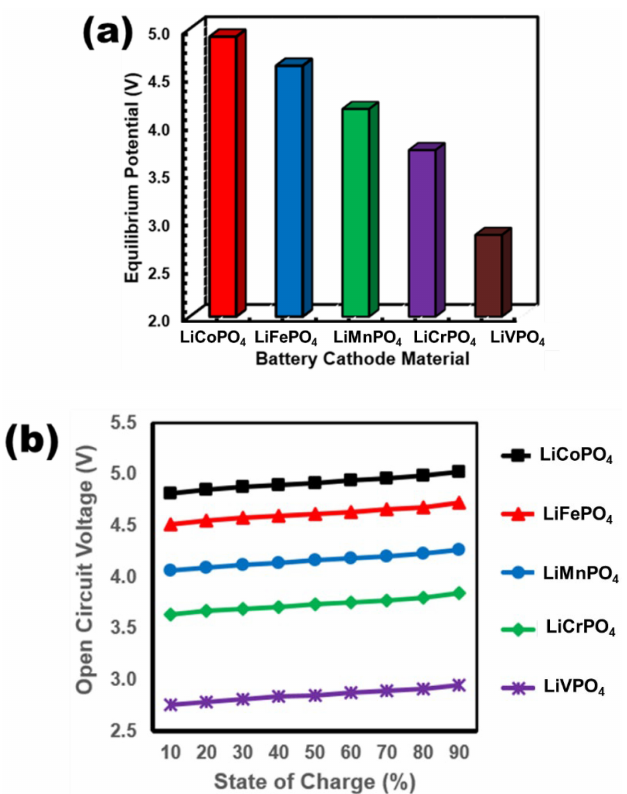
Figure 8. Comparative plots of ( a ) equilibrium potential and ( b ) open-circuit voltage as a function of state of charge for different LiMPO 4 cathode